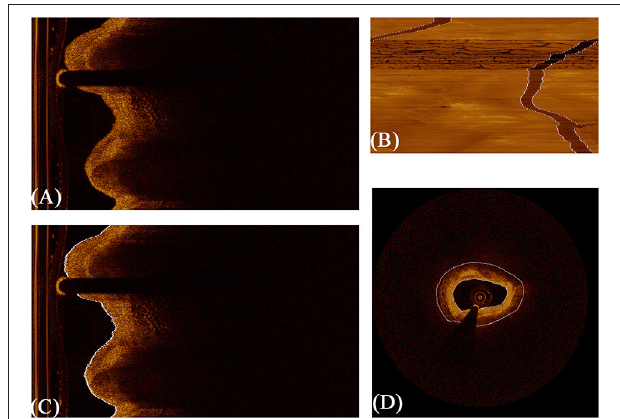
FIGURE 4 | The procedure of fully automated lumen segmentation based on dynamic programming. (A) shows the original image in polar coordinate. (B) shows the concentration of average intensity of each frame; the guidewire line region became a continuous dark band traversing the whole image. (C) shows the lumen segmentation result with guidewire line exclusion, and (D) shows the regions of interest (vascular tissue, the region between the two white lines) segmented by the